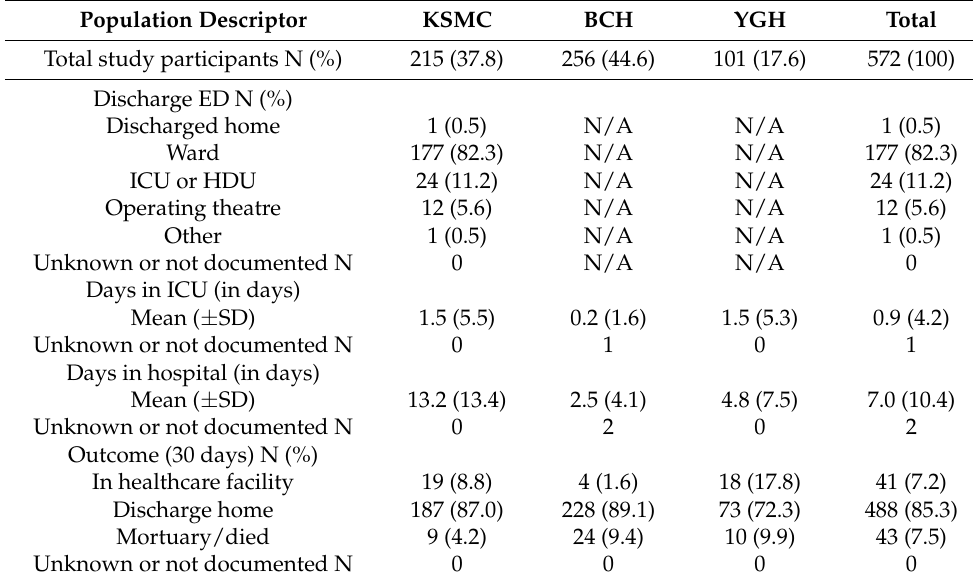
Table 4. Thirty-day patient outcome following a traffic